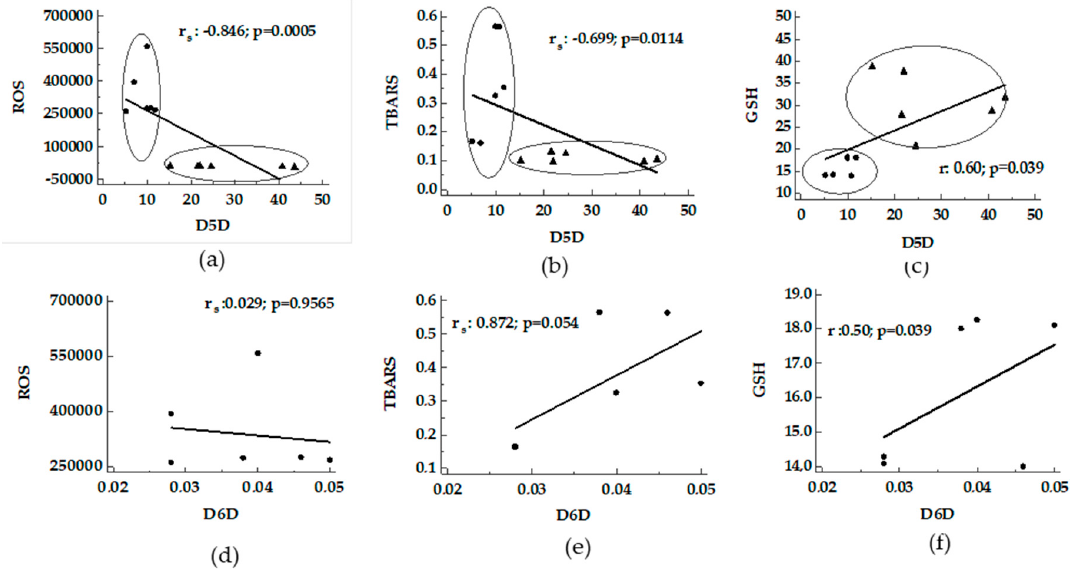
Figure 1. Correlation between desaturase activity indexes and oxidative stress in livers from MCD and Obese Zucker rats. Panels ( a – c ), D5D activity index versus ROS, TBARS and GSH; panels ( d – f ), D6D activity index, detected only in MCD rats, versus ROS, TBARS and GSH. • : MCD rats; (cid:78) : Obese Zucker rats. TBARS, thiobarbituric acid reactive substances; ROS, reactive oxygen species; GSH, glutathione. A negative correlation between D9-16D versus ROS and TBARS supported by a positive correlation with GSH was shown (Figure 2, panel a–c). On the contrary, a positive correlation between D9-18D versus ROS and TBARS supported by a negative correlation with GSH was shown (Figure 2, panel